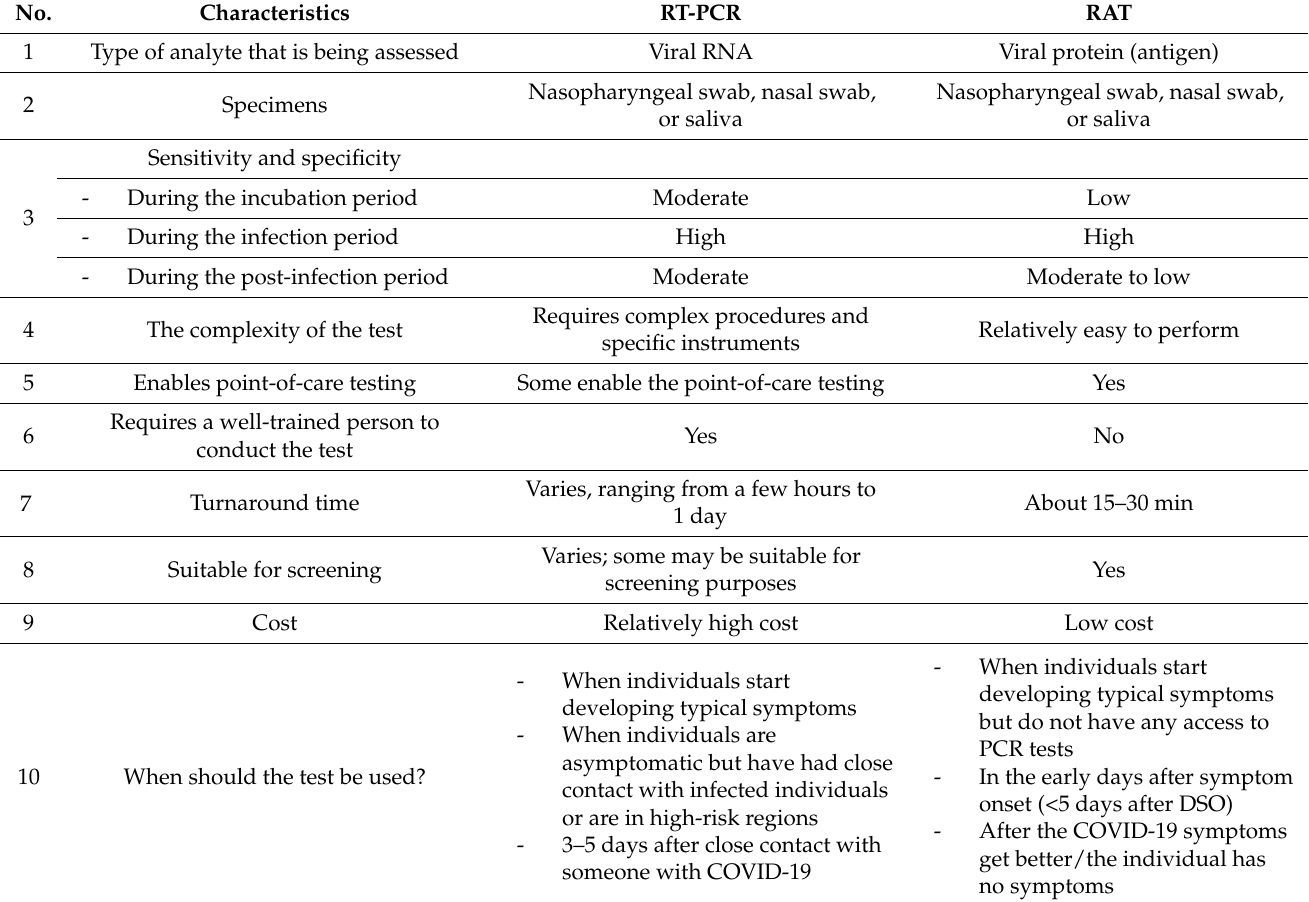
Table 2. Characteristics of RT-PCR and RATs for COVID-19